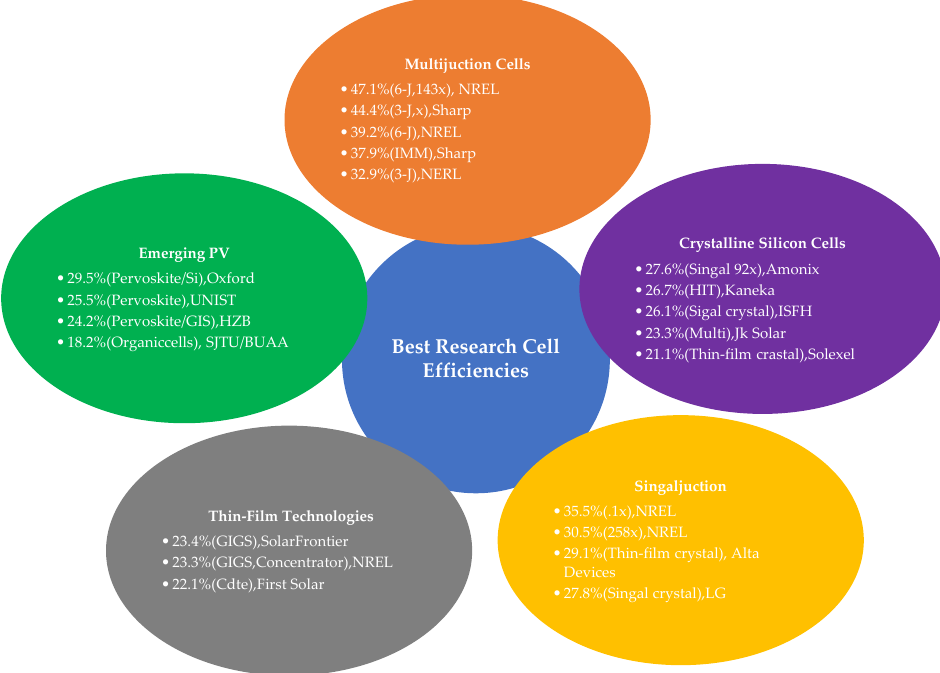
Figure 12. Overview of all the technical roadmaps of solar cells. Notes: Chinese solar PV players are focused on crystalline silicon solar cells. Source: Nation Renewable Energy Laboratory: https://www.nrel.gov/pv/cell-efficiency.html (accessed on 24 April 2021).